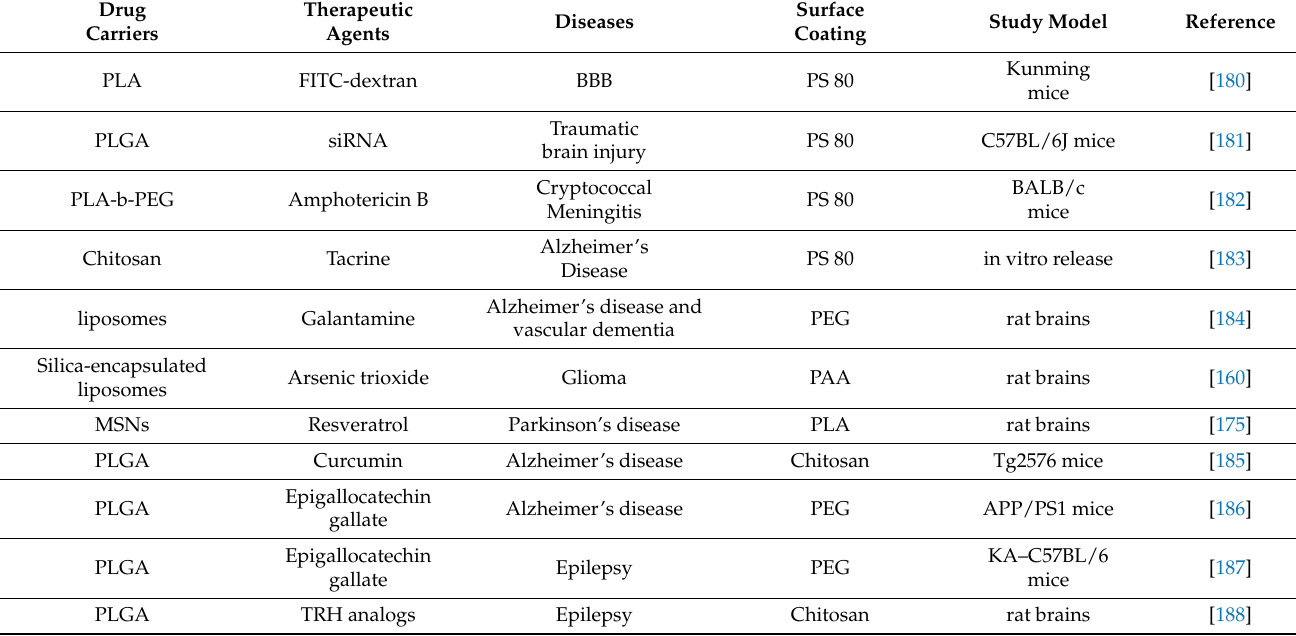
Table 3. Various polymer-coated nanoparticles for brain-targeted